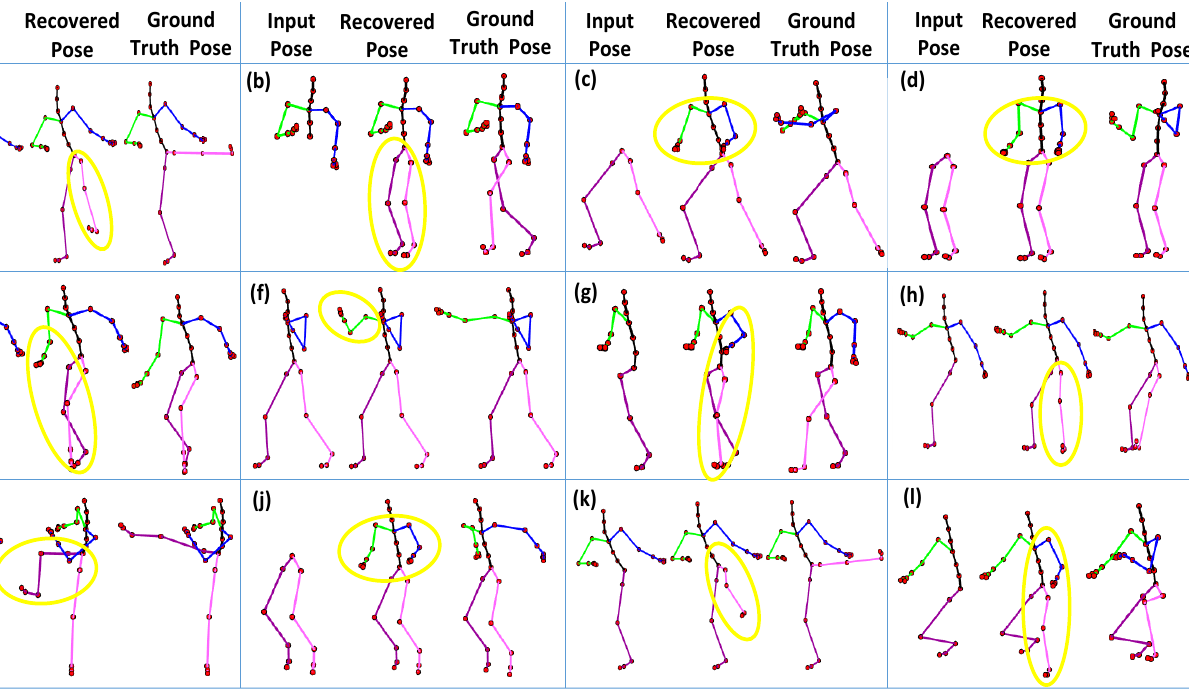
Figure 18. A few worst or failure cases of 3D recovery when all the joints of a whole body part are missing. ( a ) Kicking (all the joints of the lower body part are missing); ( b ) Acrobat ( lower body part ); ( c ) Martial arts ( upper body part ); ( d ) Salsa ( upper body part ); ( e ) Basketball ( right body part ); ( f ) Boxing ( right arm ); ( g ) Run fig8 ( left body part ); ( h ) Jumptwist ( left leg ); ( i ) Kicking ( right leg ); ( j ) Jumping ( upper body part ); ( k ) Kicking ( left leg ); ( l ) Martial arts ( right body part ). The yellow circles point towards the incorrect recovery of missing